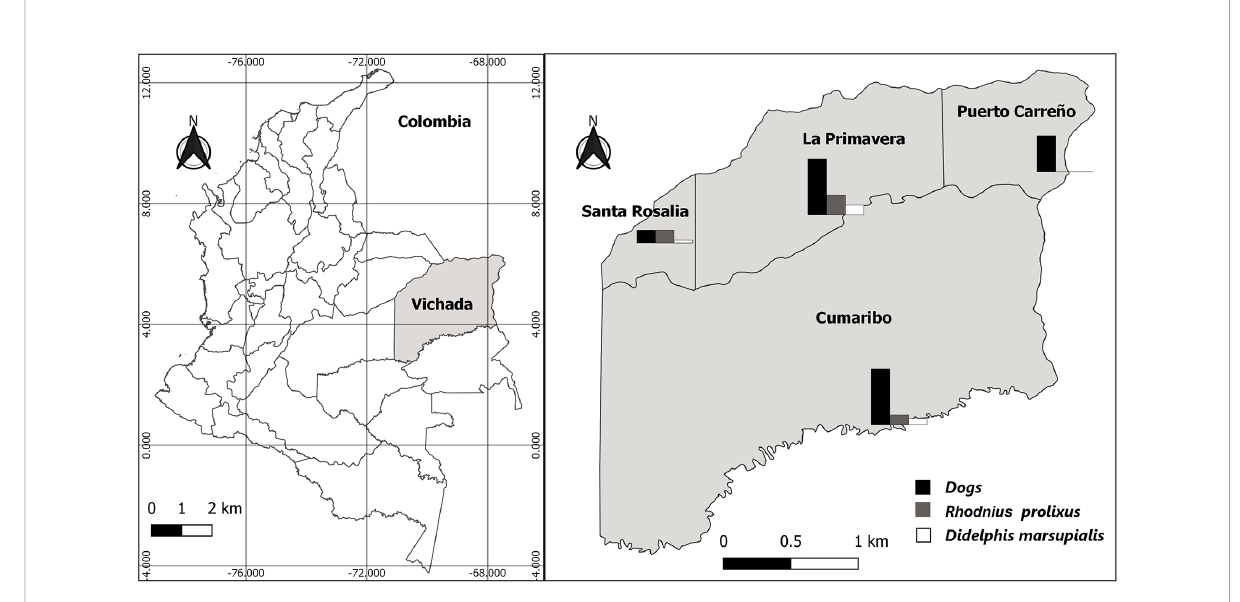
FIGURE 1 Study area and seroprevalence to Trypanosoma cruzi in dogs, frequency of infection of triatomine bugs, and Didelphis marsupialis distributed by each municipality in Vichada Department,